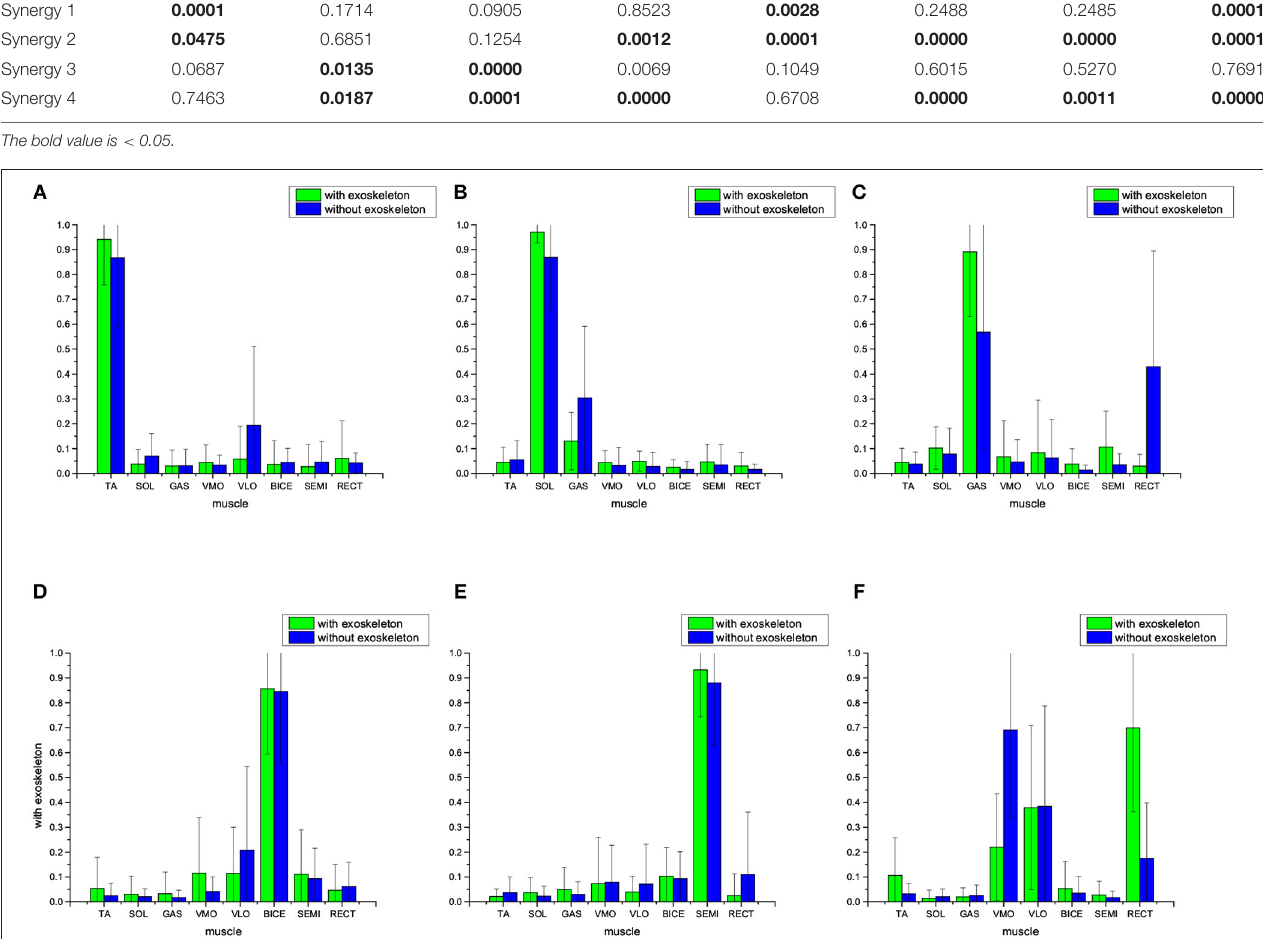
FIGURE 5 | Average muscle synergy of the 17 subjects who walked with and without lower-limb exoskeletons. NMF was used to exact the muscle synergy with reduced dimension being k = 6. (A) Synergy 1, (B) Synergy 2, (C) Synergy 3, (D) Synergy 4, (E) Synergy 5, and (F) Synergy 6.